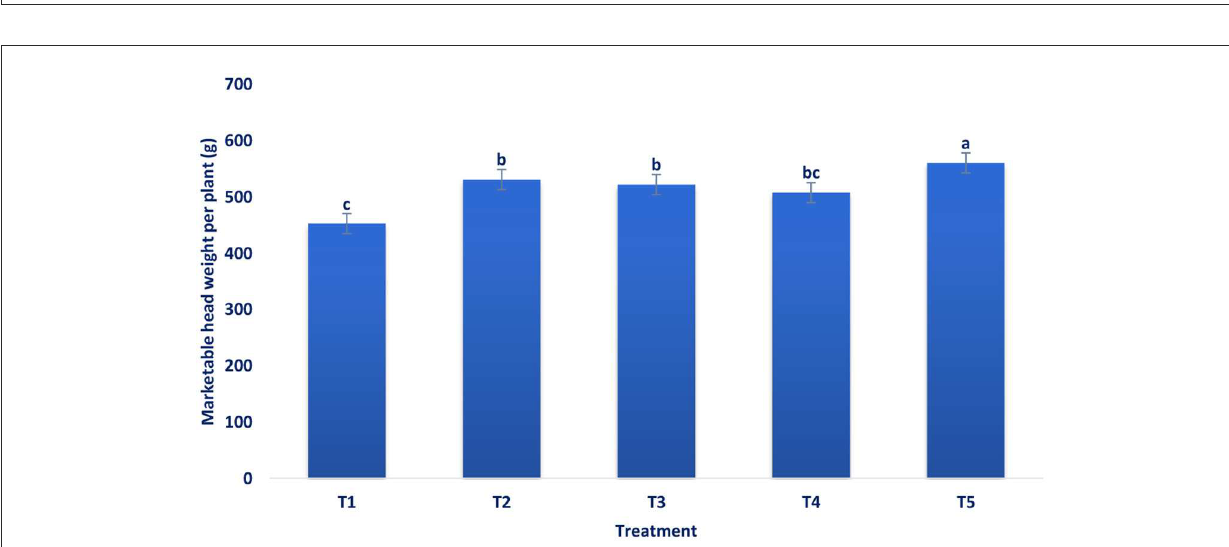
FIGURE2 Influence of pre-harvest foliar application of mineral nutrients on marketable head weight plant − 1 (g) of broccoli at the marketable stage. T 1 = control, T 2 = B, T 3 = Zn, T 4 = Mo, and T 5 = B + Zn + Mo, 0.40%,